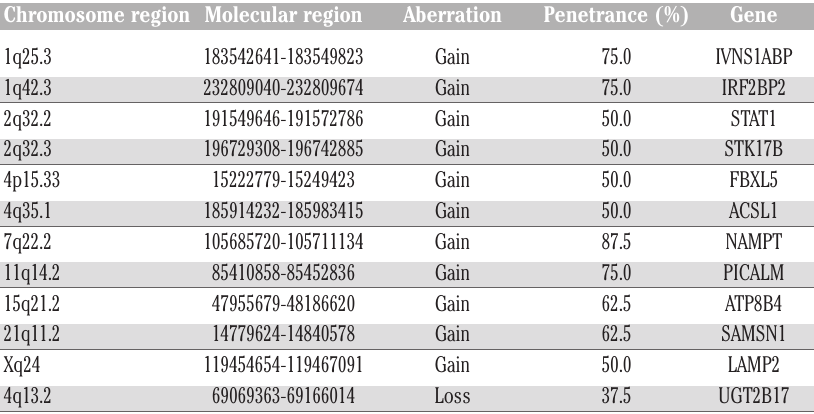
Table 3. Gene list and the per cent penetrance of chromosomal aberration